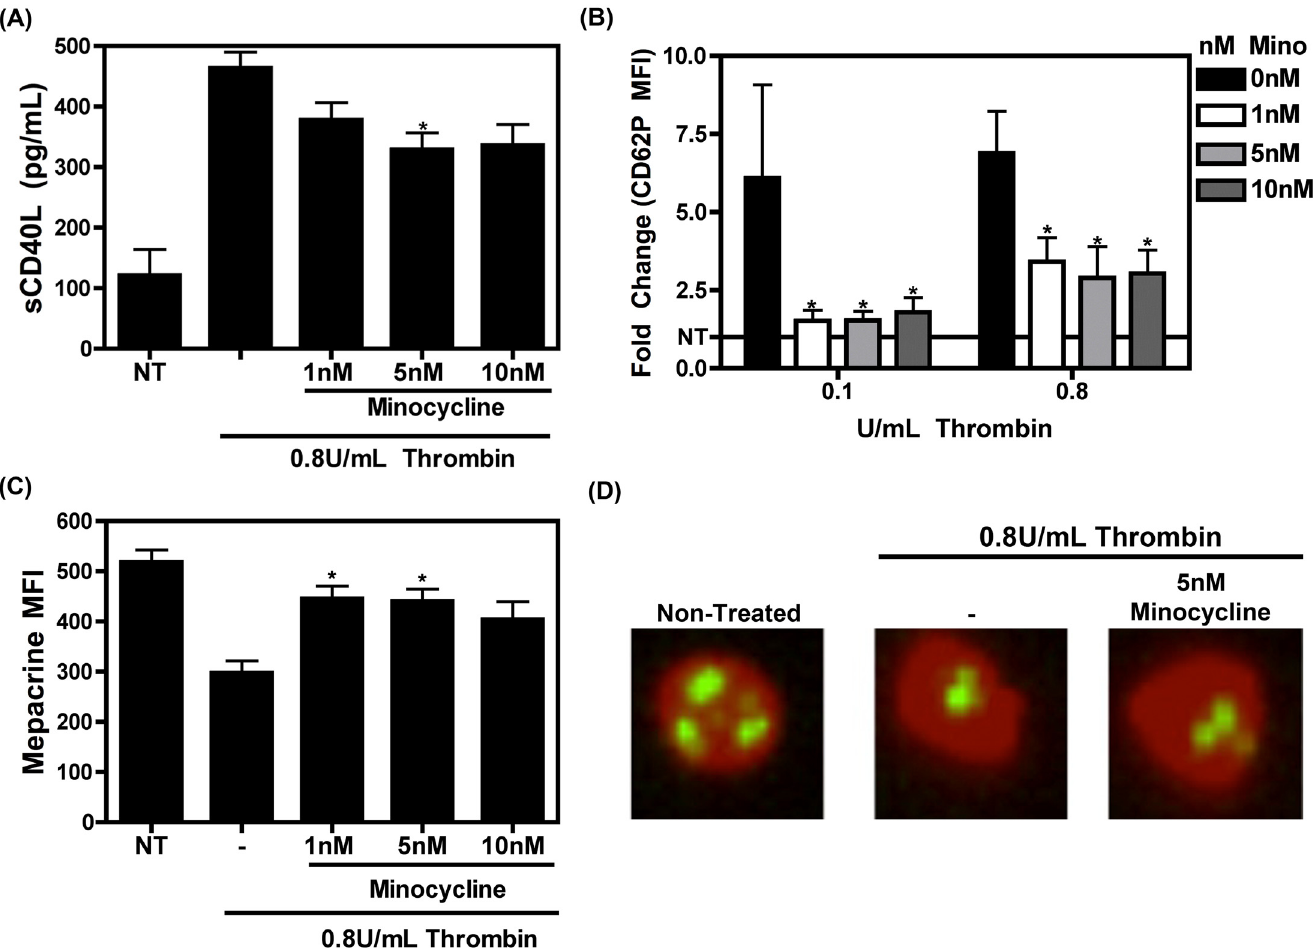
Fig 2. Minocycline reduces activation of human platelets in vitro . Platelets from healthy, seronegative donors were isolated and activation was assessed via (A) measurement of sCD40L levels by ELISA after treatment with thrombin alone or together with minocycline, or (B) measurement of CD62P (P selectin; a platelet activation marker) median fluorescent intensity (MFI) by flow cytometry. Data from (B) is presented as fold change of CD62P MFI normalized to non-treated (NT) samples (visualized by horizontal black line set at 1). Data sets for (A) were compared using a one way ANOVA statistical test and data sets for (B) were compared using a two way ANOVA statistical test followed by Bonferroni ’ s test for multiple comparisons, where * denotes p < 0.05. Data shown is representative of three separate experiments. (C) Platelet degranulation was assessed via measurement of mepacrine retention by flow cytometry. The data is representative of three separate experiments and was compared using a one way ANOVA statistical test followed by Bonferroni ’ s test for multiple comparisons, where * denotes p < 0.05. (D) Representative images of mepacrine retention in platelet granules as analyzed by Amnis Image Stream following the indicated treatments. CD61 marks the platelet surface (in red), and mepacrine is stored in platelet dense granules (in green).